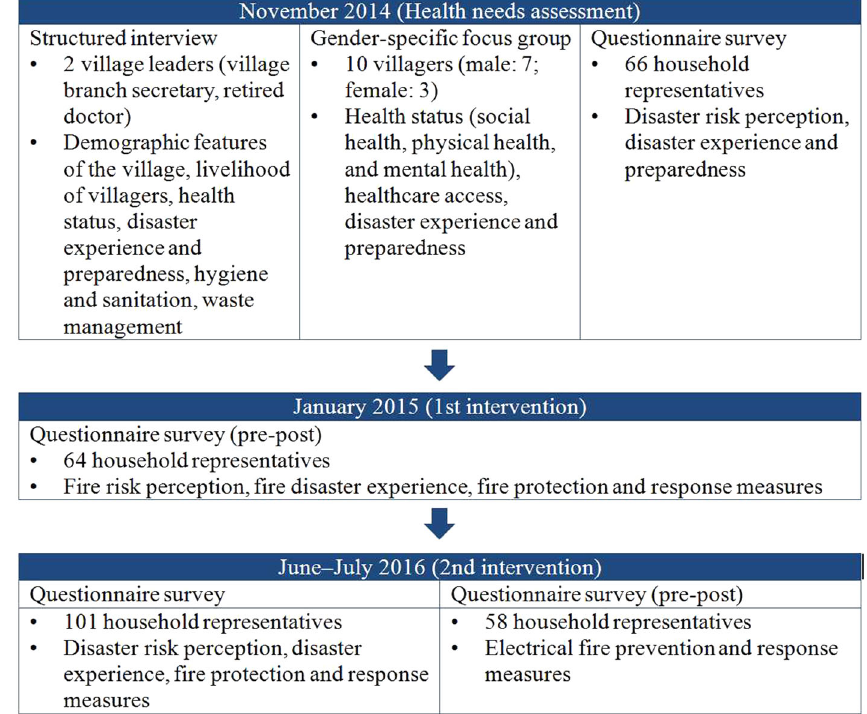
Fig. 2 Outline of the 2014–2016 field program on fire risk and its data collection activities in Nanjiang Village, Guizhou Province,